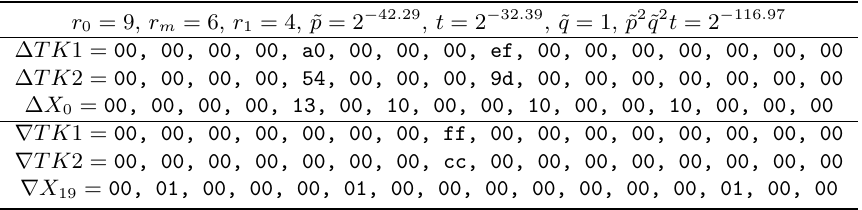
Table 6: The 19-round related-tweakey boomerang distinguisher for SKINNY-128-256